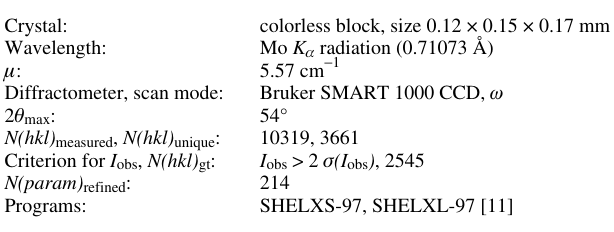
Table 1. Data collection and handling.